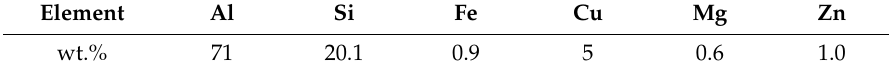
Table 1. The chemical compositions of the Al–Si alloy cylinder liner.